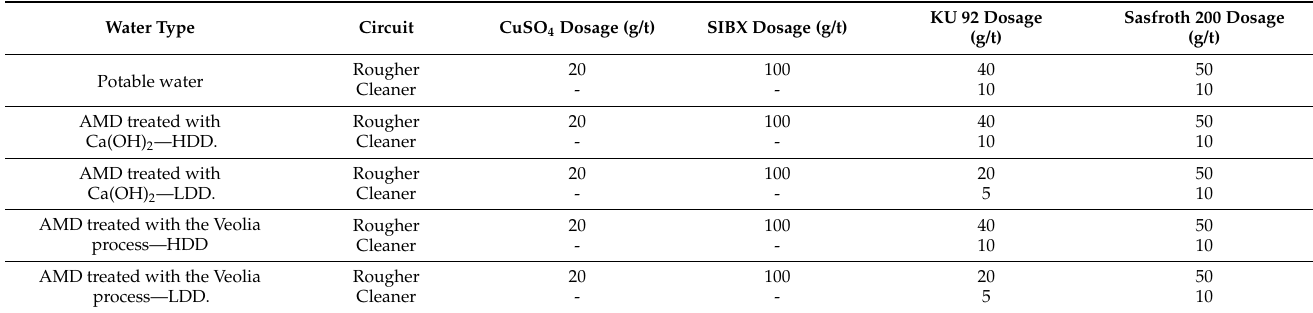
Table 3. Summary of all flotation tests conducted in this study.